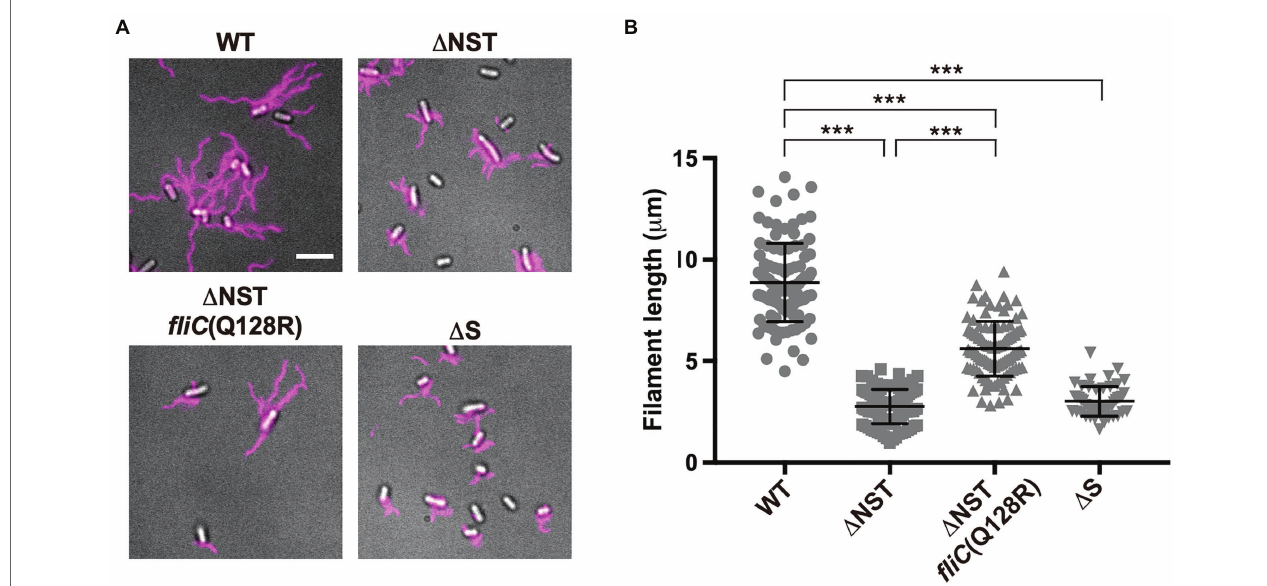
FIGURE 3 | Effect of deletion of FliS on filament length. (A) Fluorescent images of the WT, ∆ NST, ∆ NST fliC (Q128R), and ∆ S cells. The cells were grown in L-broth until the cells reached the stationary phase, and then, flagellar filaments were labelled with a fluorescent dye, Alexa Fluor 594. The fluorescence images of the filaments labelled with Alexa Fluor 594 (magenta) were merged with the DIC images of the cell bodies. Scale bar, 5.0 μ m. (B) Scatter plots of flagellar filament length. Filament length is the average of 50 filaments, and vertical lines are standard deviations. Comparisons between datasets were performed using a two-tailed Student’s t -test. A value of p < 0.05 was considered to be statistically significant difference. ***, p < 0.001 (also see Supplementary Table 1